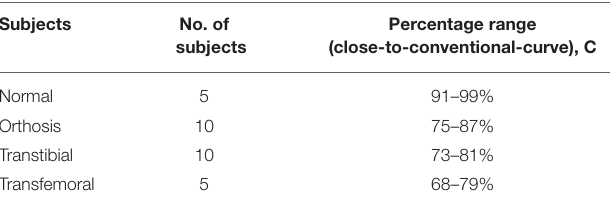
TABLE 3 | Percentage range of closeness between networks predicted output curve and conventional trials averaging curve.